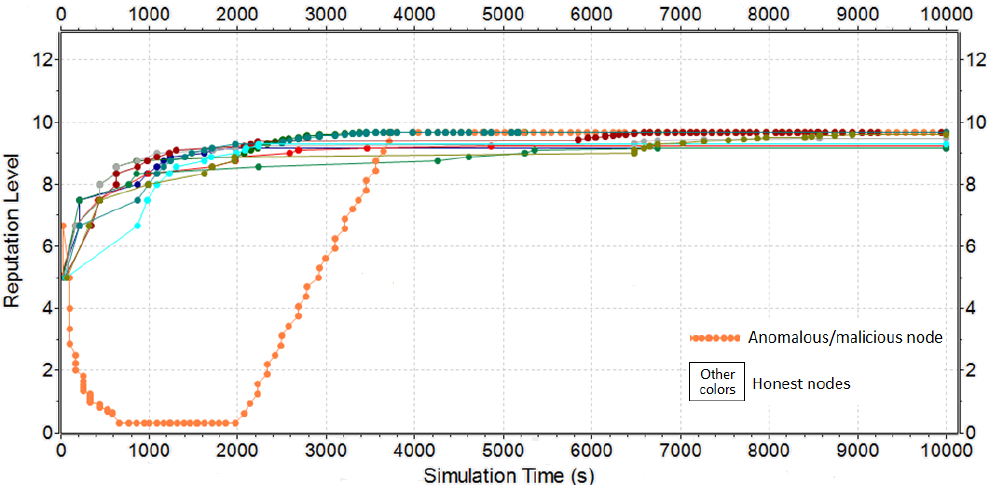
Figure 5. Reputation evolution for newcomer attack—restricted scenario.